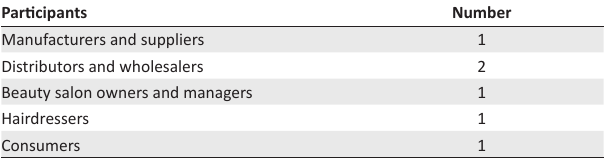
TABLE 2: Sample size of the qualitative approach. Participants Number